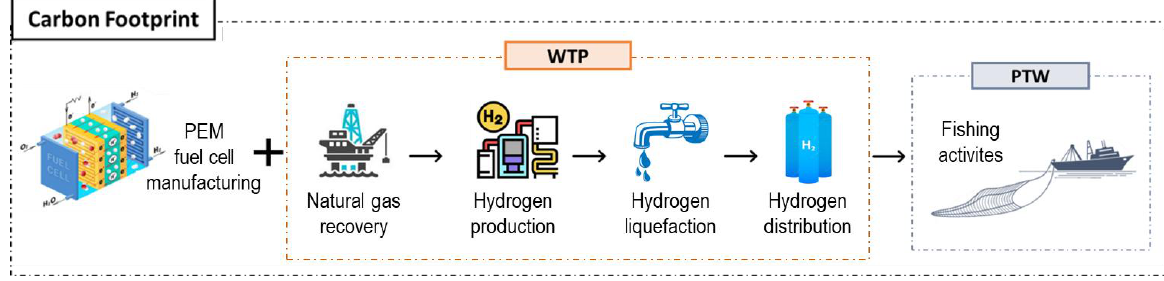
Figure 11. The LCA of a hydrogen-powered trawler.